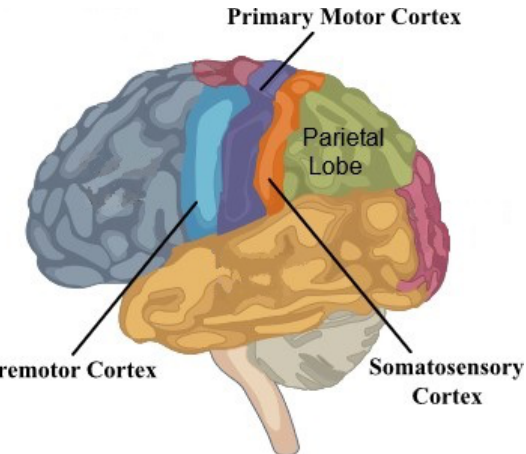
Figure 1. Some of the brain areas activated during creative behavior